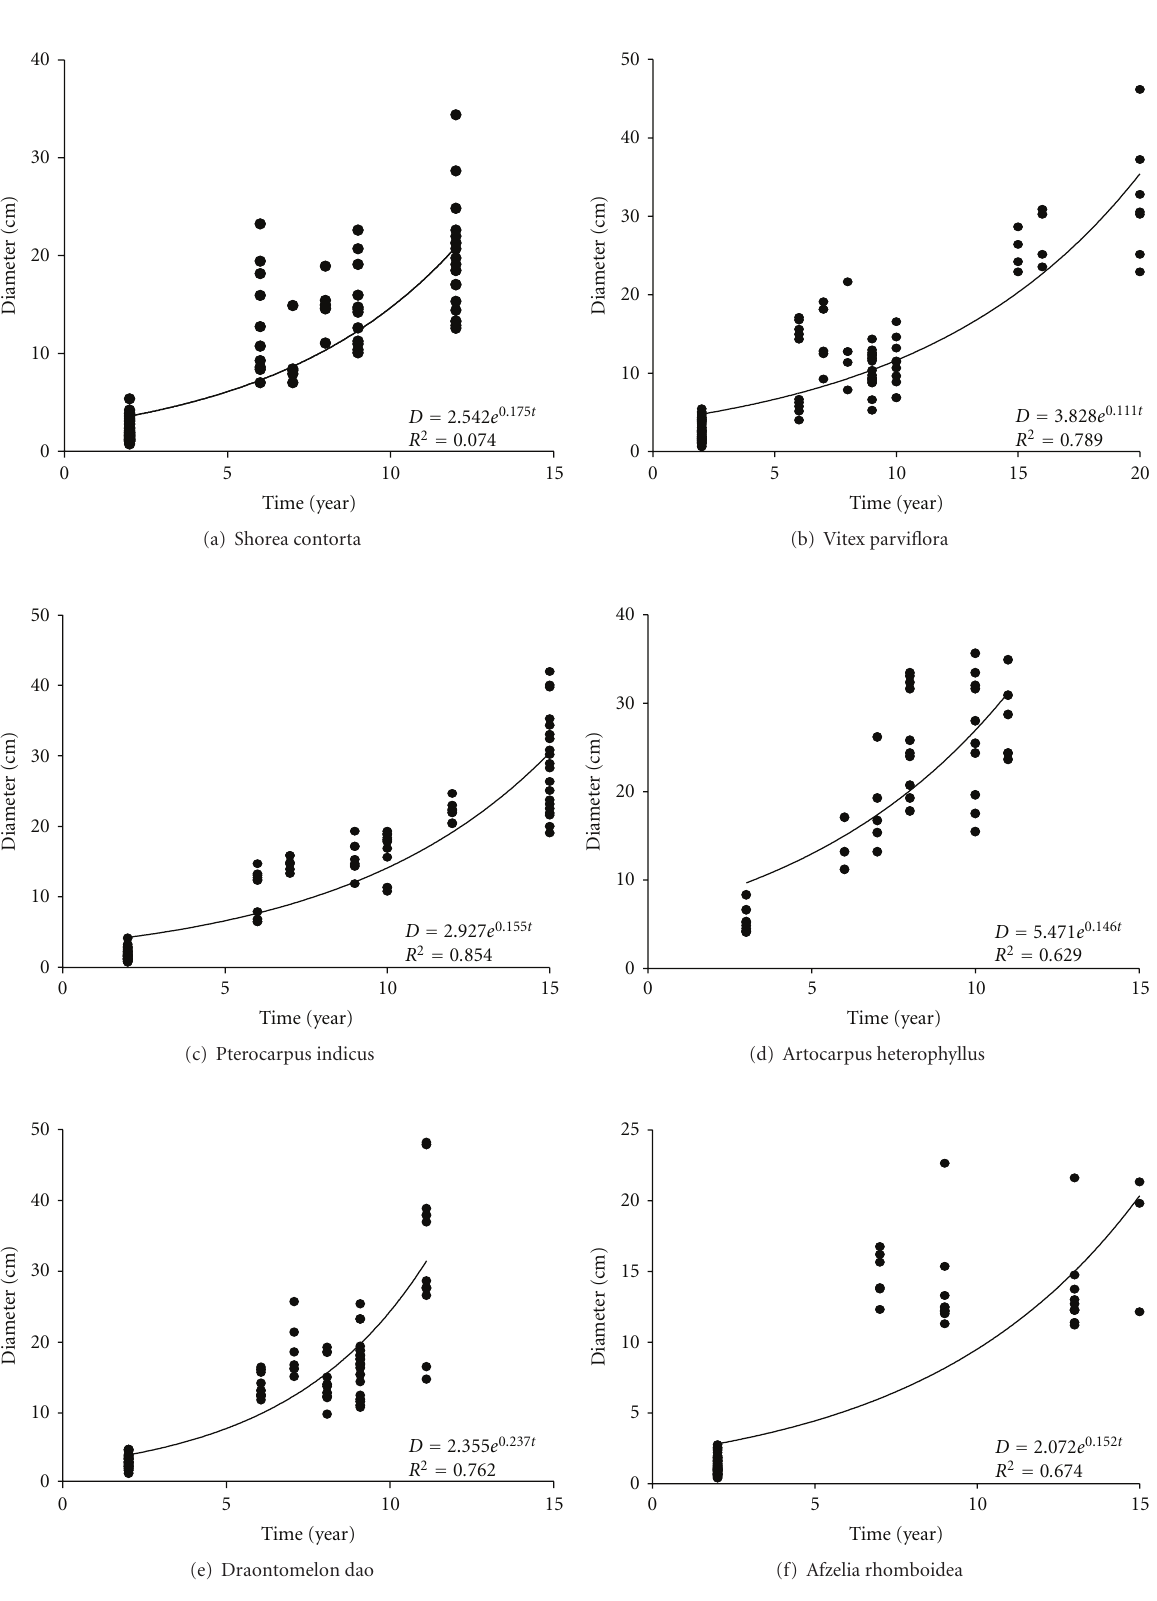
Figure 2: Reference growth functions for six native tree